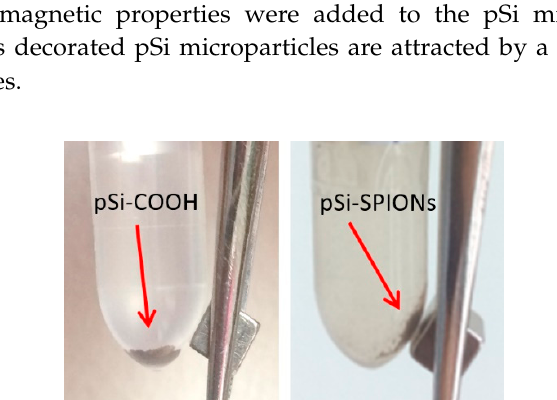
Figure 7. STEM images of: ( a ) a non-porous pSi microparticle after SPIONs decoration at 50 nm scale; elemental mapping of: ( b ) Si; ( c ) Fe; ( d ) O.